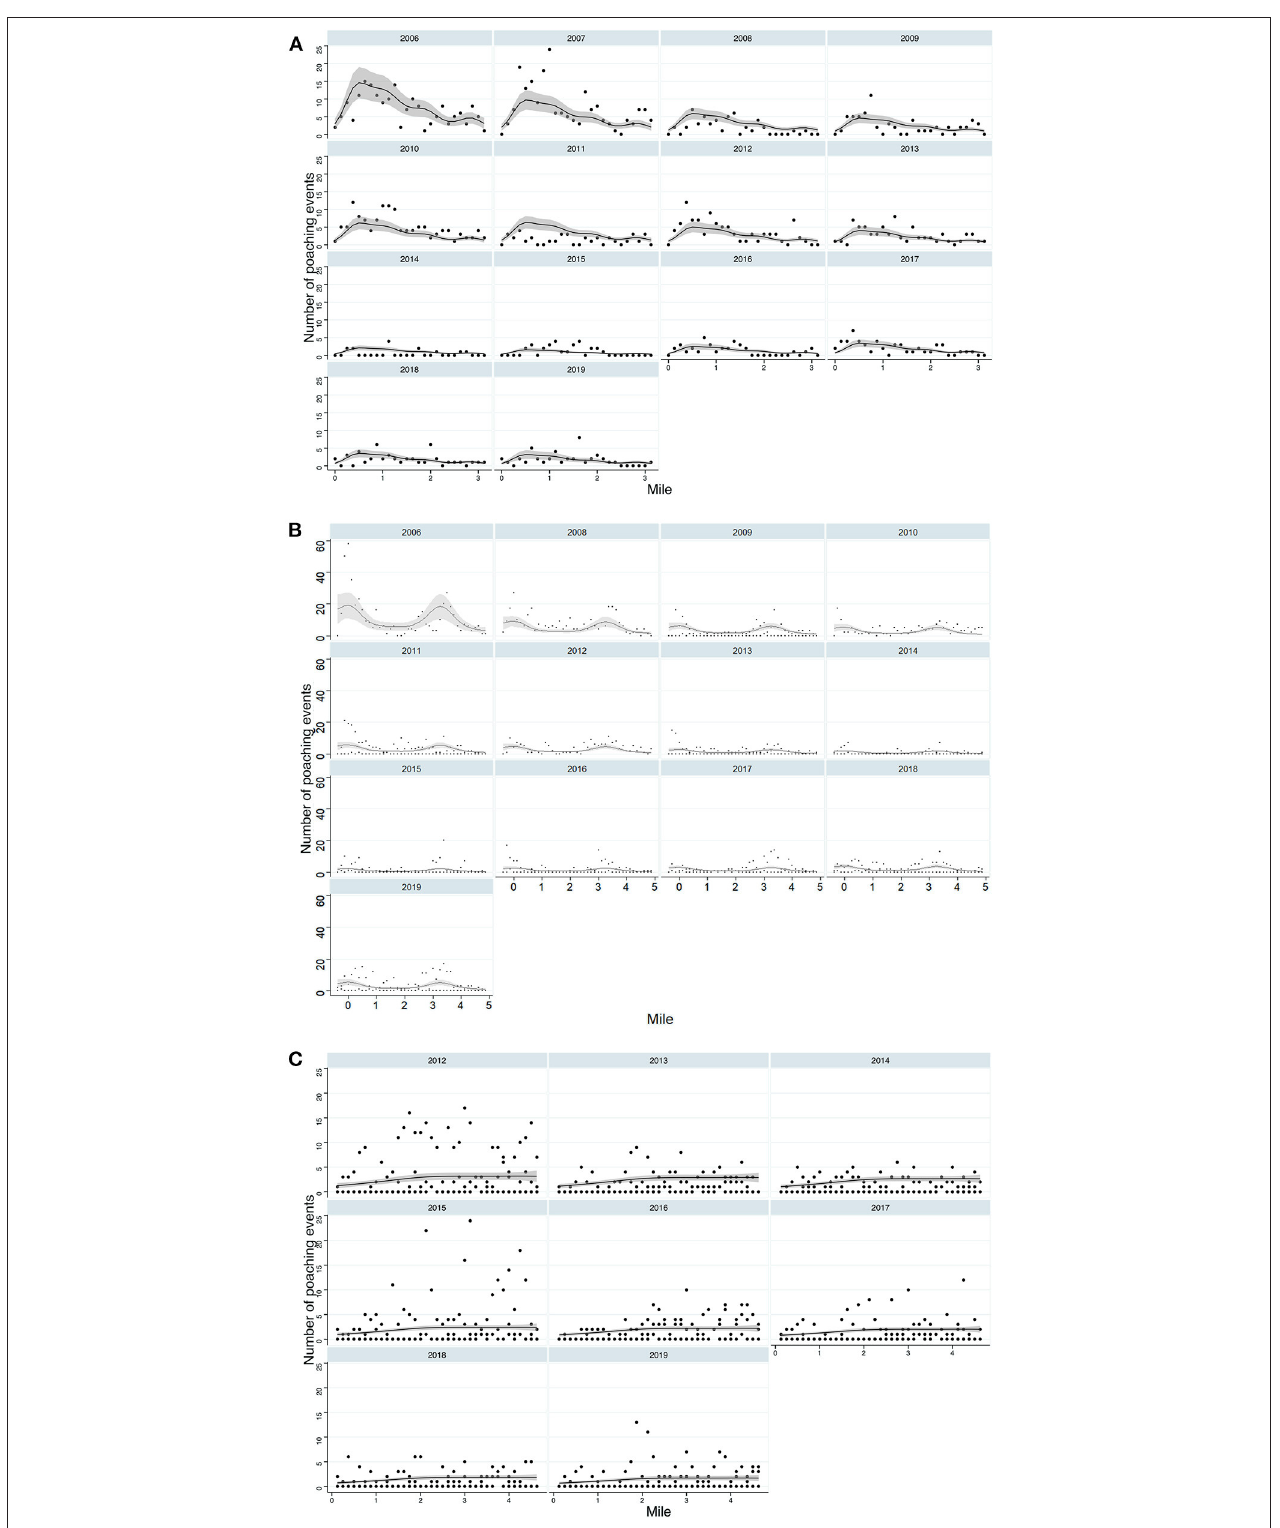
FIGURE 2 | Spatiotemporal distribution of poaching on each beach, (A) Playa Norte, (B) Tortuguero (C) Pacuare. This includes females and nests. Solid line indicates the model fit and the grey shaded areas are 95% CI.